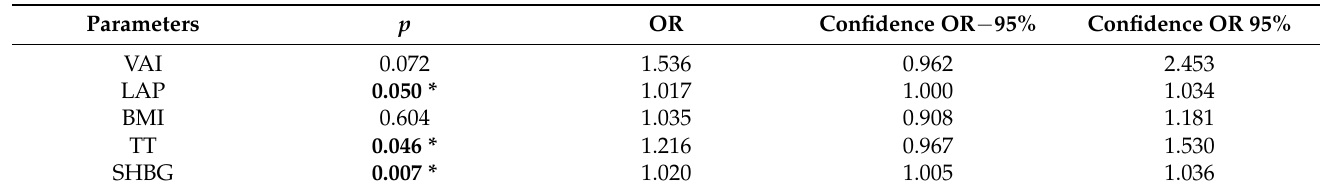
Table 4. Multivariate logistic regression explaining the International Index of Erectile Function score, adjusted for